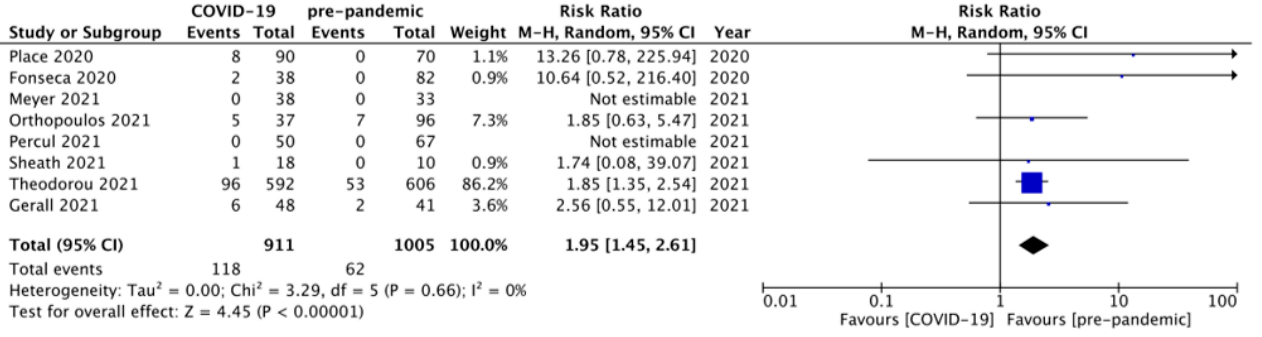
Figure 3. Forest plot comparison of the non-operative management (NOM) rates between the two groups of patients, i.e., presenting during the COVID-19 pandemic versus the pre-pandemic period. COVID—Coronavirus Disease 2019; M-H—Mantel–Haenszel method; CI—confidence interval.